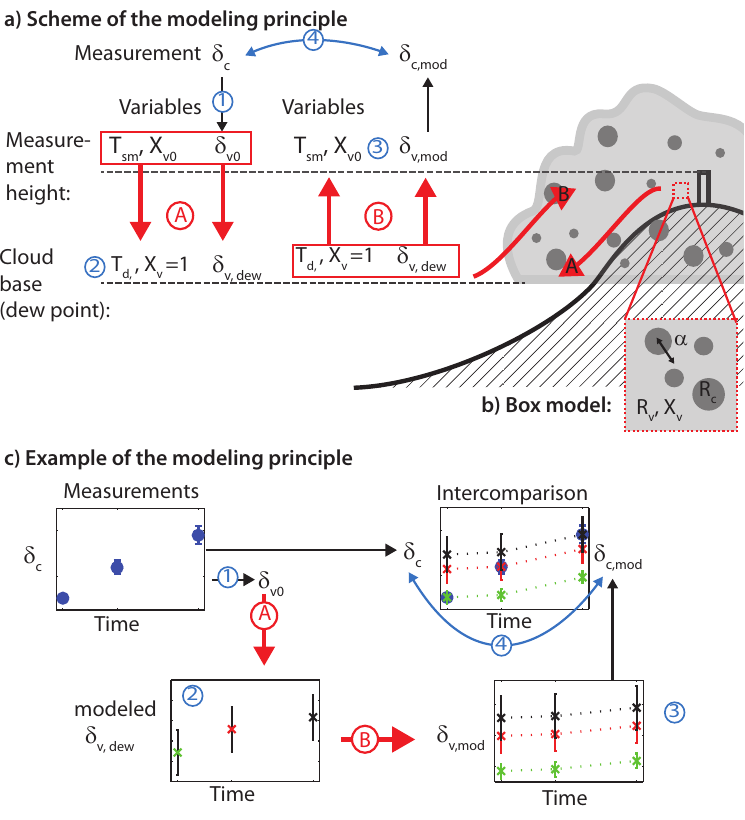
Fig. 2. (a) Sketch of a cloud forming at Schm¨ucke including the box model approach (b) consisting of the two model runs A and B. The initial values of each model run are framed in red. (c) An example of the modeling principle as described in Sect. 2.4 (variables are explained there as well): from the measured δ c (blue dots), δ v0 is derived 1 (cid:13) leading to δ v , dew after model run A 2 (cid:13) . Starting with each of the δ v , dew , model run B produces a series (three in total for the case shown here) of locally thermodynamically driven δ v , mod 3 (cid:13) , from which δ c , mod were deduced and in a last step compared to the measured time series of δ c 4 (cid:13) . In this example, the transition between the last two measurement points meet the local condensation criterion, because both measured values δ c are within the errors of modeled values δ c , mod (cloud sample 2 is within the black error bar, which shows the uncertainty of the δ c , mod based on δ v , dew of cloud sample 3 and wise versa). In contrast, the error bar of δ c , mod based on δ v , dew of cloud sample 1 (green) does not overlap with cloud sample 2 (and the red error bar not with cloud sample 1). So, the transition from the first to the second measurement point is found to be caused by changes in the water vapor isotope composition feeding the